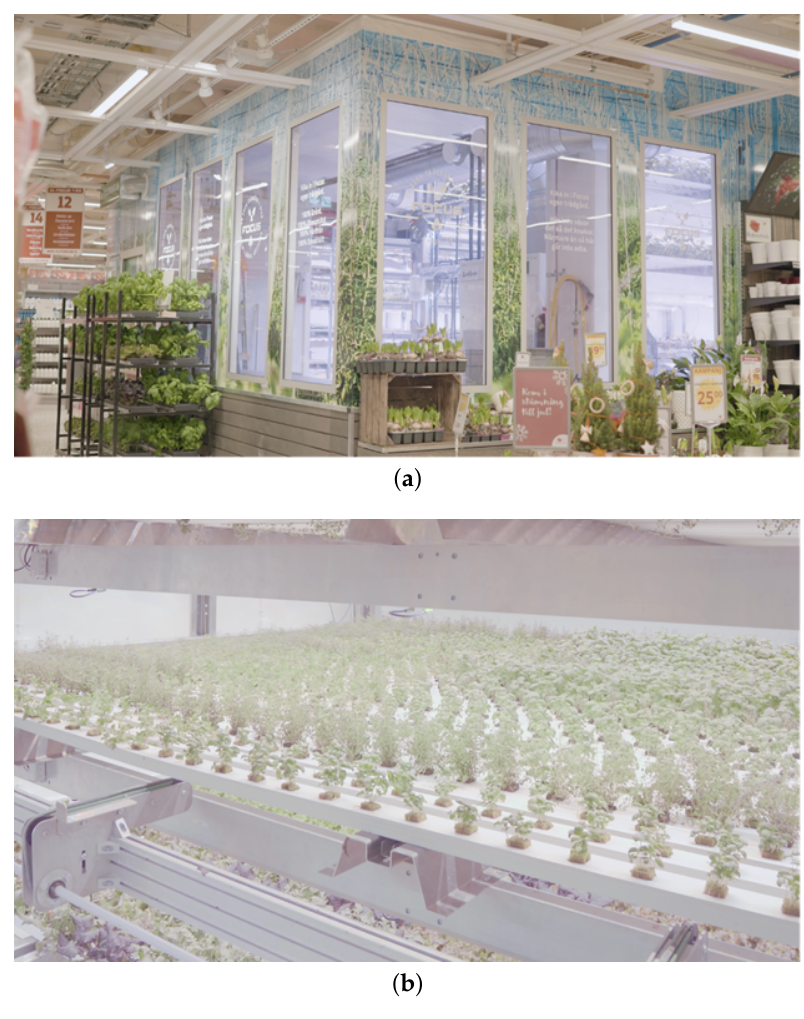
Figure 4. ( a ) SweGreen’s industrial practice of vertical farming in a store in Sweden. ( b ) Growing tracks of a fully-automated farming as a service unit of SweGreen in the testbed environment